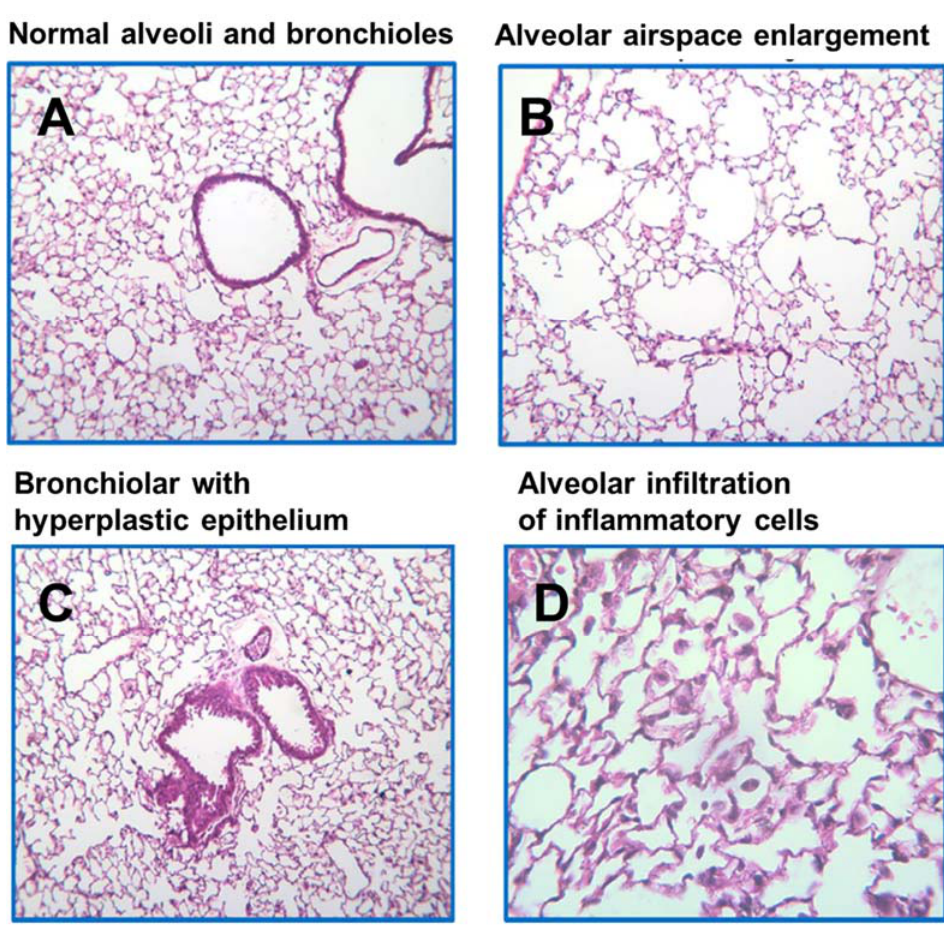
Figure 2. Histopathologic examination of lung tissues of BCO1 − / − /BCO2 − / − DKO mice exposed to CS or not. Representative image of an H&E-stained lung at 40 × (four-micrometer sections). ( A ) normal alveoli and bronchiolar of non-CS-exposed control group. Fourteen days of CS exposure significantly induced ( B ) alveolar airspace enlargement, ( C ) bronchiolar with hyperplastic epithelium, and ( D ) alveolar infiltration of inflammatory cells in DKO mice. H&E, hematoxylin and eosin. CS, cigarette smoke; BCO1, β -carotene-15,15 ′ -oxygenase; BCO2, β -carotene-9 ′ ,10 ′ -oxygenase; DKO, double knockout.